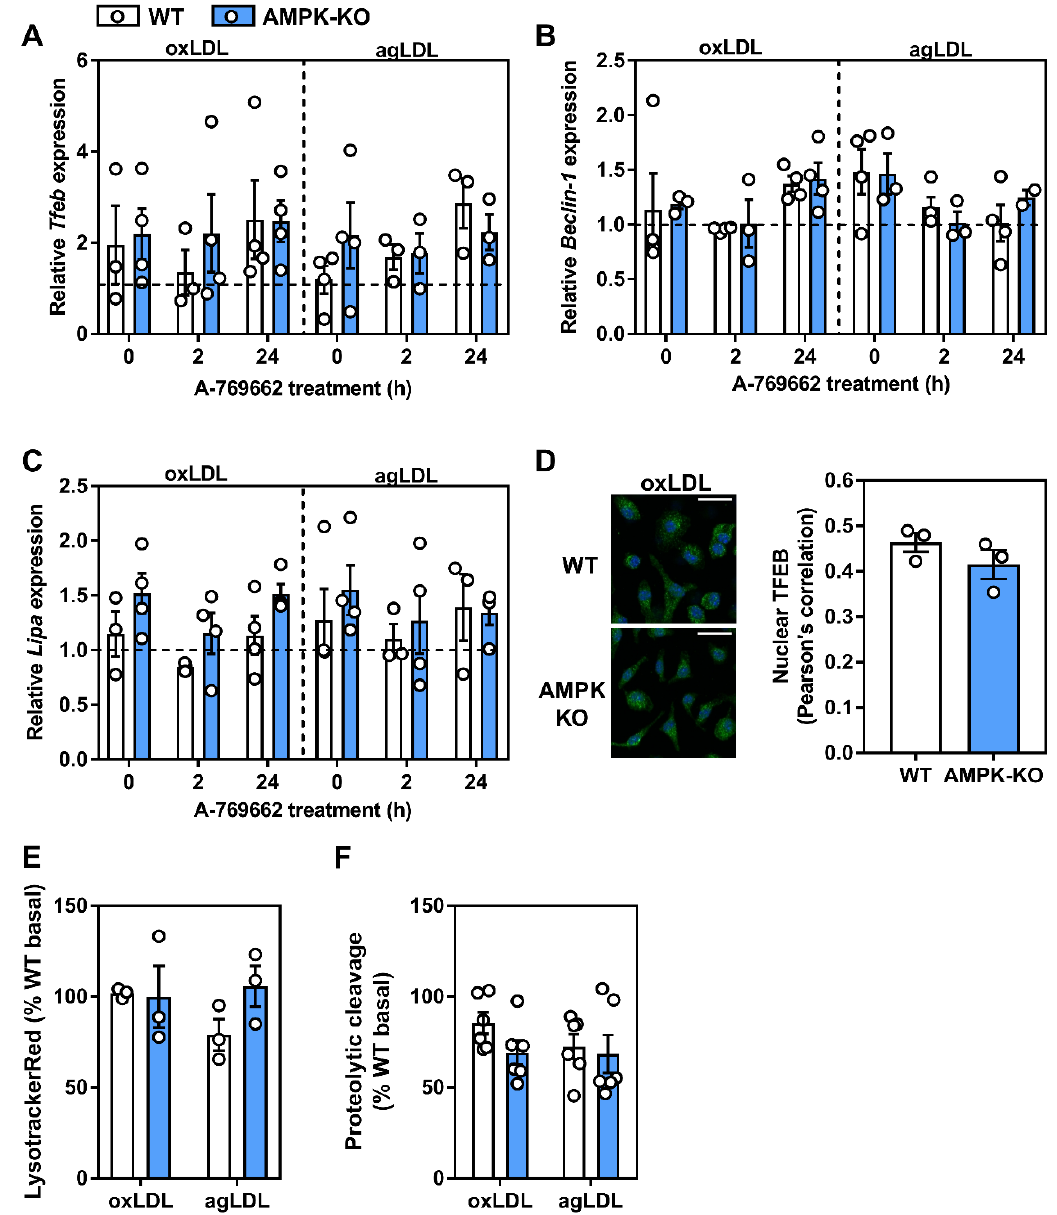
Figure 9. Atherogenic lipoproteins uncouple AMPK from its regulation of lysosomal-associated gene transcription. WT and AMPK β 1-deficient macrophages were cultured for 48 h in ox-LDL- or agLDL-containing media (50 µ g / mL each), followed by a 24 h-treatment with A-769662 (100 µ M). Relative transcript expression of ( A ) Tfeb , ( B ) Beclin-1 and ( C ) Lipa (lysosomal acid lipase) was determined by normalizing to the average of β actin and Tbp . The horizontal hashed line represents the expression of untreated WT BMDM. ( D ) WT and AMPK β 1 knockout cells were treated with oxLDL (2 h; 50 µ g / mL) and imaged. Representative immunofluorescent image z-projection for maximum intensity, scale bar was 25 µ m (TFEB; Green, DAPI; Blue). Pearson’s correlation coefficient quantification of the entire z-stack (right). WT and AMPK β 1-deficient cells were co-cultured with oxLDL and agLDL (50 µ g / mL) for 24 h followed by determination of ( E ) Lysotracker Red staining and ( F ) DQ-ovalbumin proteolytic cleavage. Data represent the mean ± SEM.